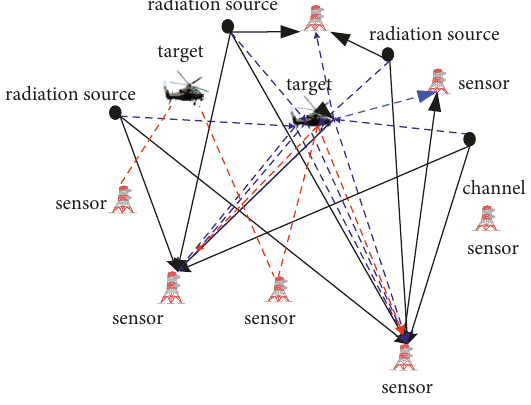
Figure 1: The electromagnetic environment characteristics group perception